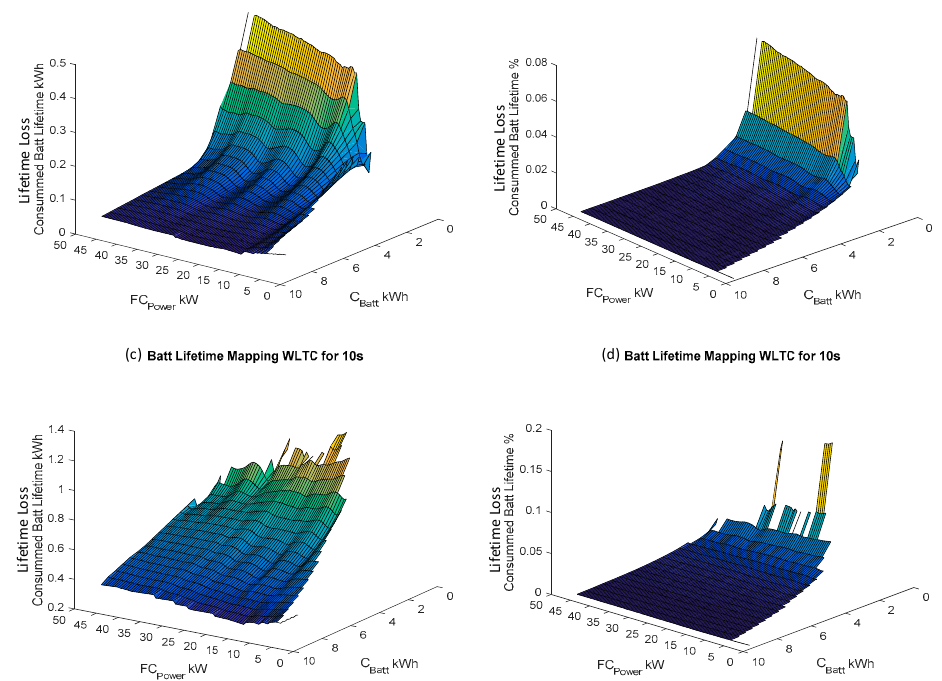
Figure 10. Design results considering lifetime loss (KW / h or %) according to US Highway and WLTC